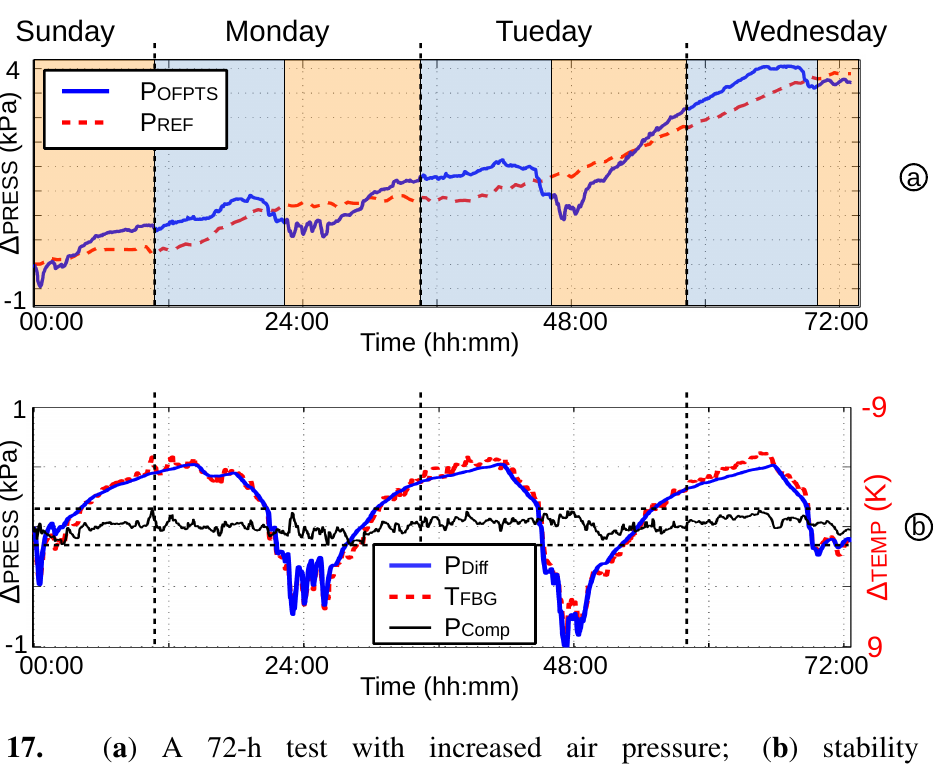
Figure 17. ( a ) A 72-h test with increased air pressure; ( b ) stability with compensated temperature.